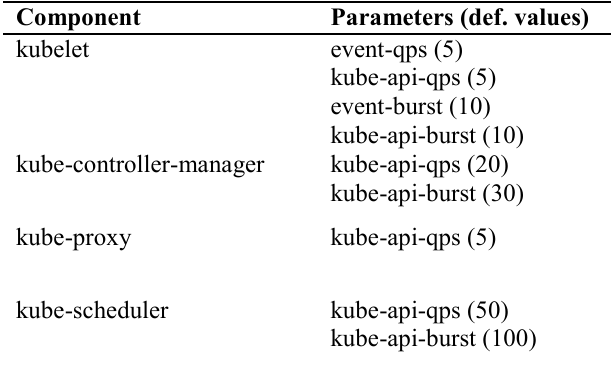
Table 1A. QPS-related command line parameters that have been modified for each Kubernetes component. Default values are reported in